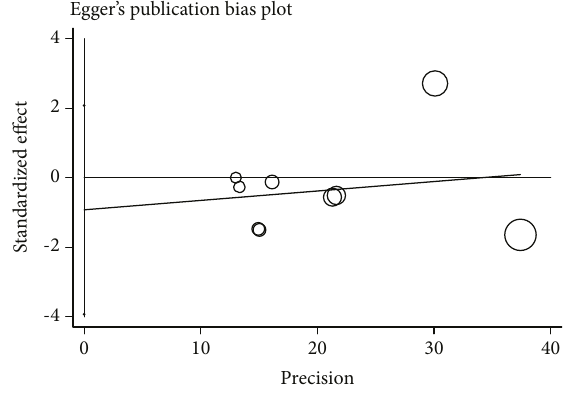
Figure 6: Egger ’ s publication bias